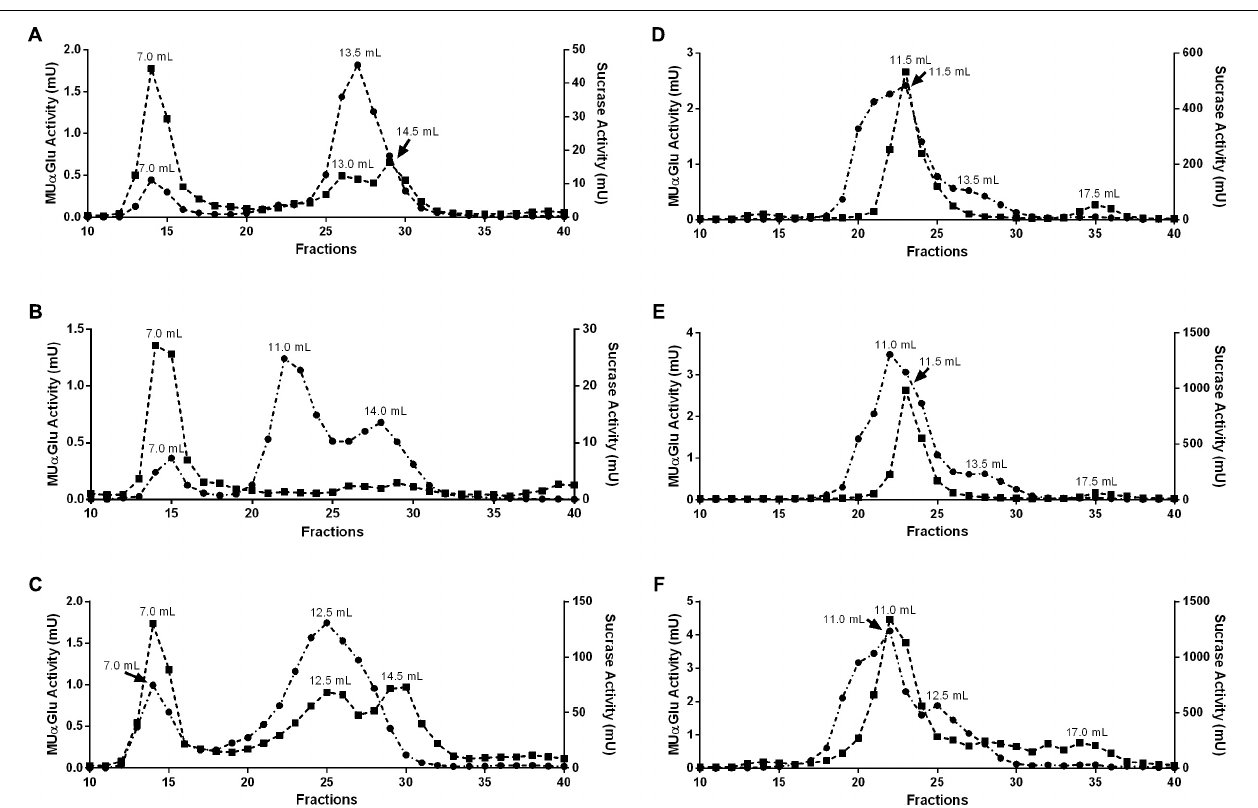
FIGURE 7 | Gel filtration chromatographies (Superdex 200 column, AKTA-FPLC) of the midgut contents (A–C) or midgut tissue samples (D–F) of L. longipalpis females. Samples were obtained from recently emerged females (0–3 h) (A,D) , females fed with 1.2 M sucrose for 2 days (B,E) and females after 2 days of blood feeding (C,F) . Activity was monitored using MU α Glu (dark circles) and sucrose (dark squares) as substrates. The elution volumes of the activity peaks are indicated in the